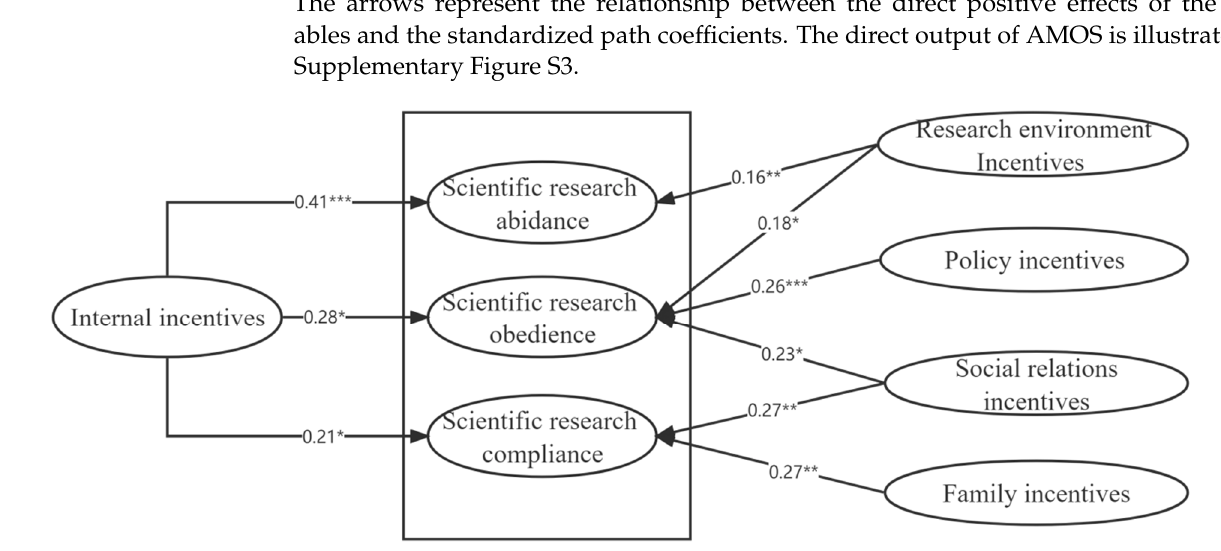
Figure 4. Results of model path analysis. (* p < 0.01, ** p < 0.05,*** p < 0.001).